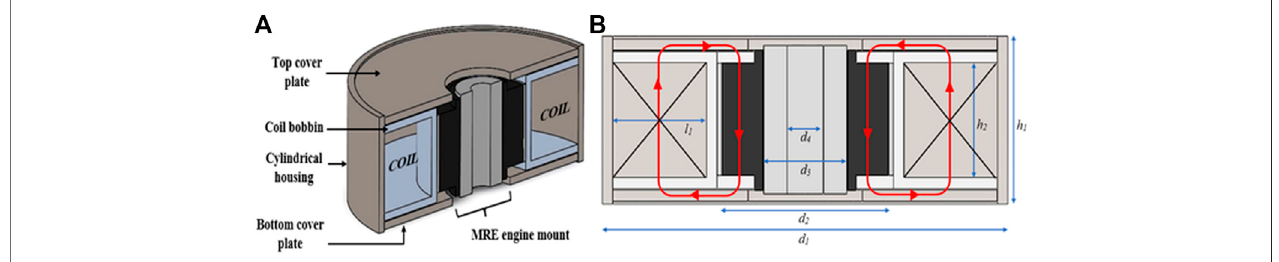
FIGURE1| Conceptualdesign (A) 3Dcross-sectionaldrawingoftheentirestructureoftheMREenginemount; (B) Schematicrepresentationoftheentirestructure of the MRE engine mount.